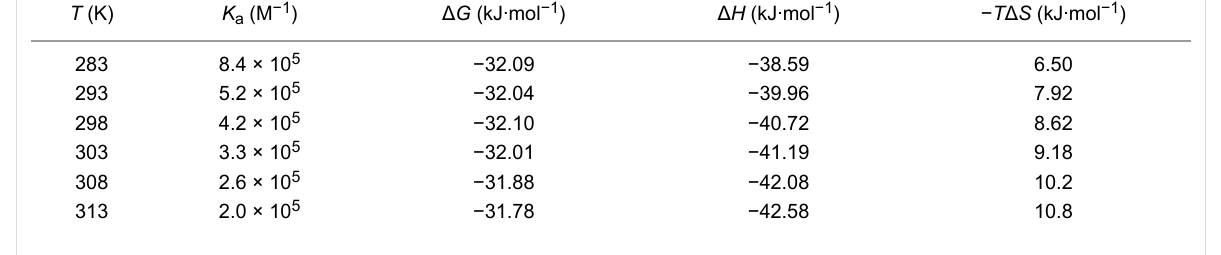
The data are compiled in Table 3. The heat capacity